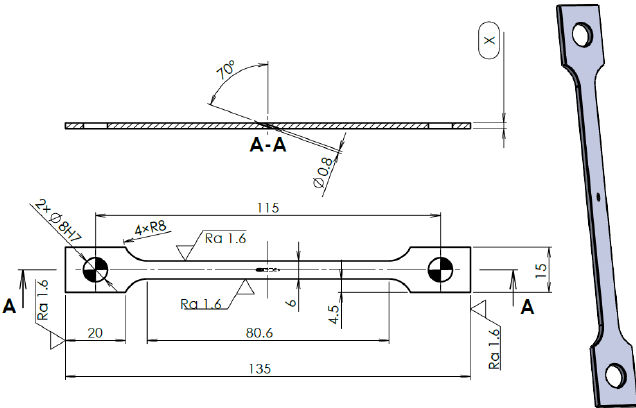
Figure 2. Design of the sample; all the dimensions in millimeters (X—sample thickness).